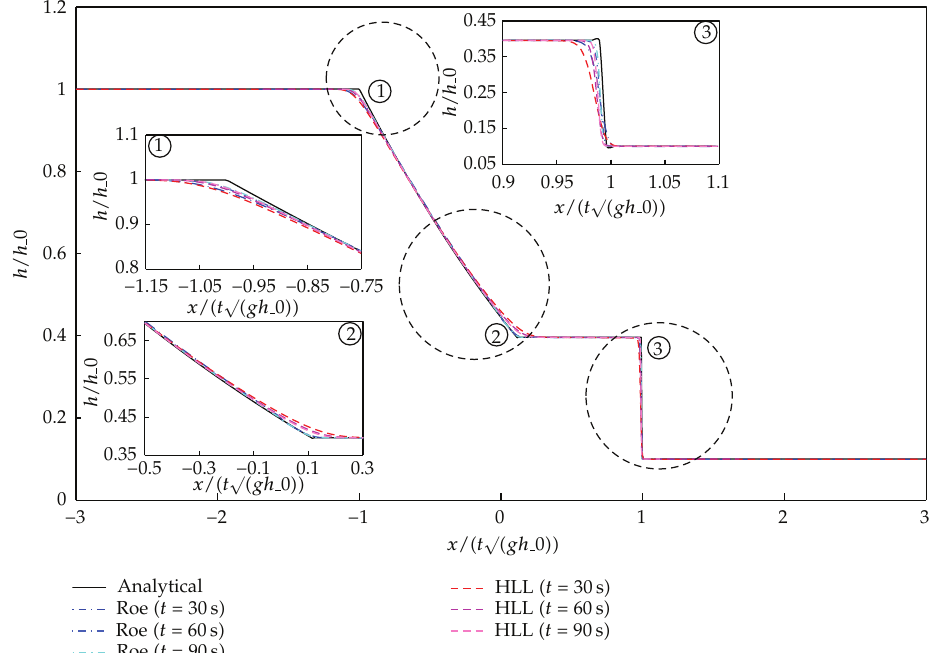
Figure 2: Increasing accuracy by decreasing the grid size to Δ x (cid:9)